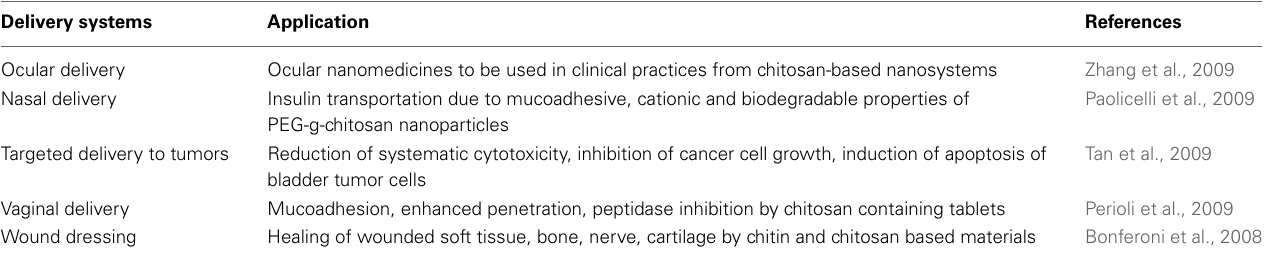
Table 1 | Successful applications of chitin and chitosan in drug